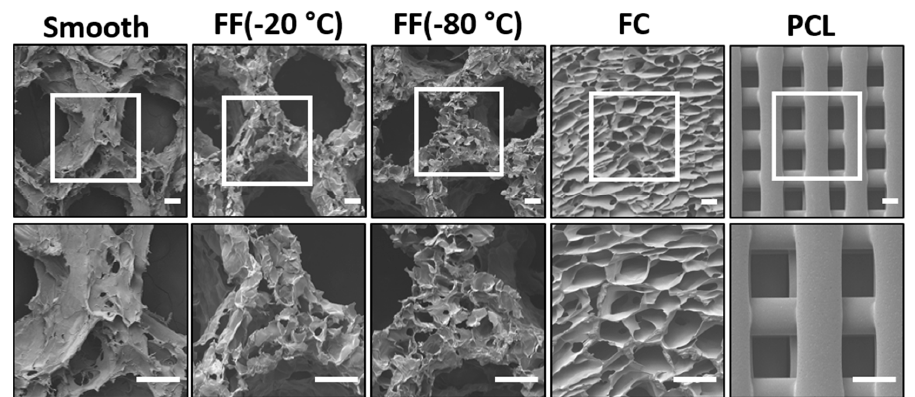
Figure 2. The FF technique produces scaffolds with hierarchical pore structures. Morphological differences in the pore structures of alginate scaffolds: smooth, FF frozen at − 20 °C and − 80 °C, FC, and PCL 3D printed scaffolds. Scale bars are 300 μ m.